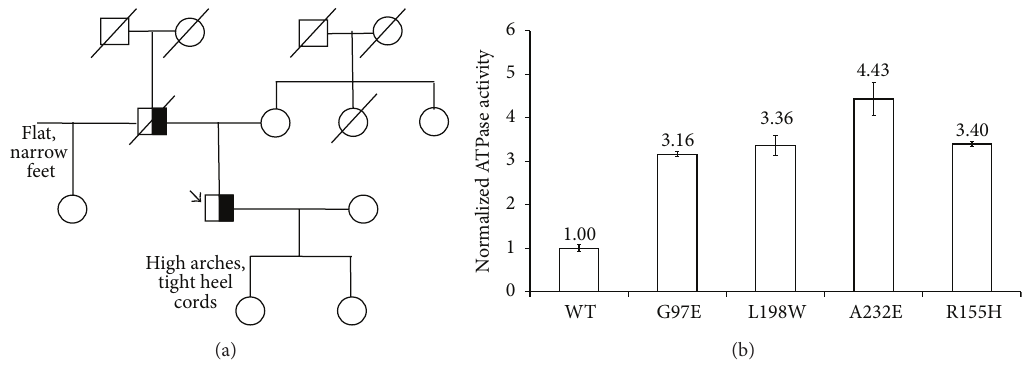
Figure 3: (a) Family Pedigree. Squares indicate men; circles, women; diagonal lines, deceased; black, VCP mutation. An arrow indicates the proband. (b) ATPase activity data that shows that the G97E (Gly97Glu mutation) has increased ATPase activity similar to other mutants. The detailed method was described previously [6]. Purified human p97 proteins (25nM monomer final concentration) were used in Assay Buffer (50 mM Tris pH 7.4, 20 mM MgCl 2 , 1 mM EDTA, and 0.5 mM TCEP) containing 0.01% Triton X-100 and 200 𝜇 M ATP. ATPase activity was determined by addition of Biomol Green Reagent (Enzo Life Sciences). Absorbance at 635 nm was measured after 4min on the Synergy Neo Microplate Reader (BioTek).